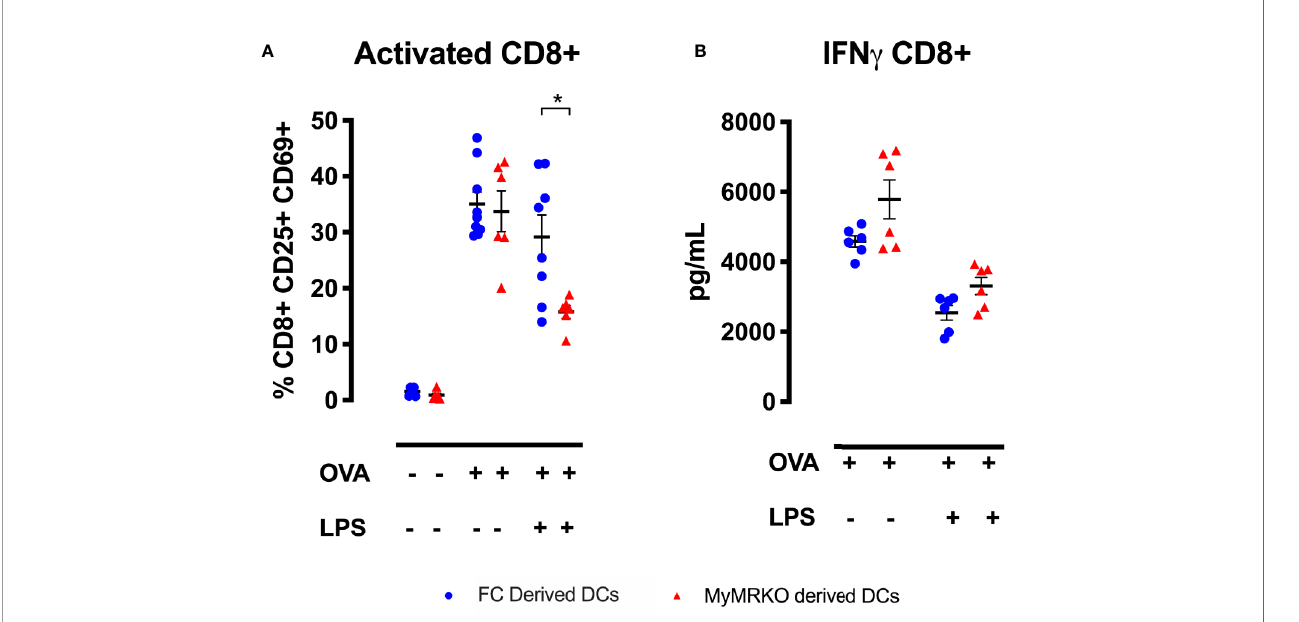
FIGURE 7 | Cocultures between OT-I lymphocytes and bone marrow-derived dendritic cells (DCs) from myleoid mineralocorticoide receptor knockout (MyMRKO) induce lower expression of activation markers CD69 and CD25. Puri fi ed CD8 + OT-I lymphocytes were cocultured with DCs in a ratio of 1:1 for 48 h. Three different conditions were tested: cocultures with DCs : CD8 + T lymphocytes without OVA peptide, untreated DCs : CD8 + T lymphocytes plus OVA peptide, and lipopolysaccharide (LPS)-pretreated DCs : CD8 + T lymphocytes plus OVA peptide (A) . Expression of activation markers CD69 and CD25 in CD8 + T lymphocytes (B) . IFN- g secretion in the supernatants by ELISA. Statistical analysis was performed with two-way ANOVA comparing all treatments, with Tukey post-test. All fi gures display mean ± SEM. Statistical differences were considered signi fi cant according to *p <